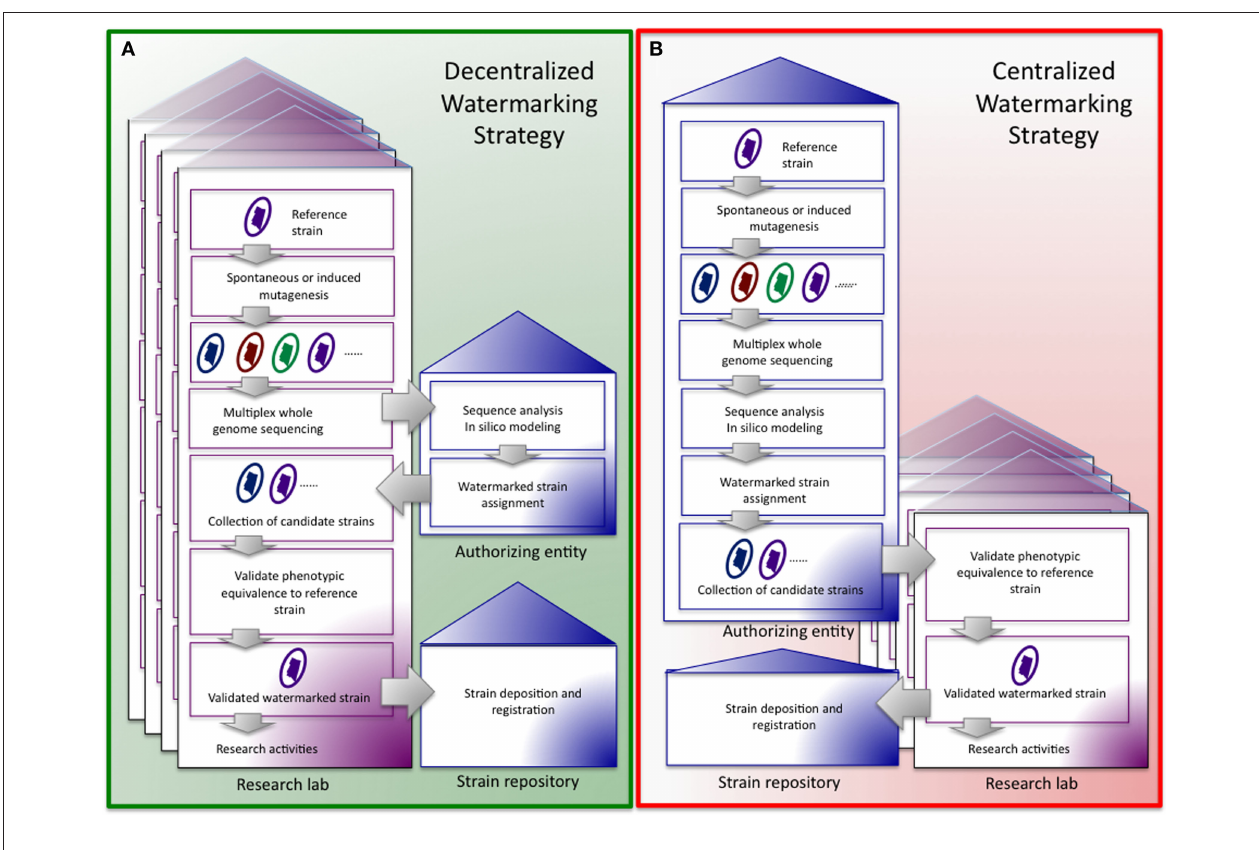
Figure 1 | Centralized vs. decentralized management of an iW watermarking system. (A) In a decentralized system the central authorizing entity takes responsibility for sequence analysis and strain assignment, after labs have sequenced genomes and induced mutations. Research entities collect candidate strains, verify phenotypic neutrality, deposit optimal strains with a strain repository, and then perform experiments with authorized, phenotypically